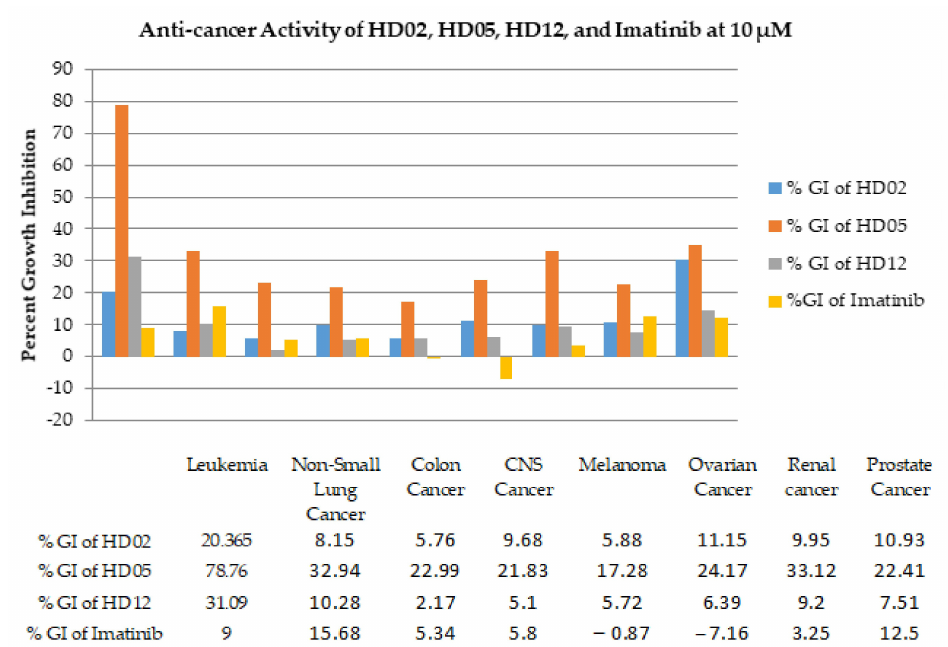
Figure 7. Comparative averaged anti-cancer activity of the compounds HD02, HD05, HD12, and imatinib at doses of 10 µ